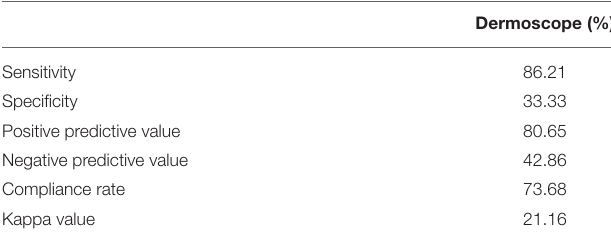
TABLE 4 | Analysis of the value of dermoscopic